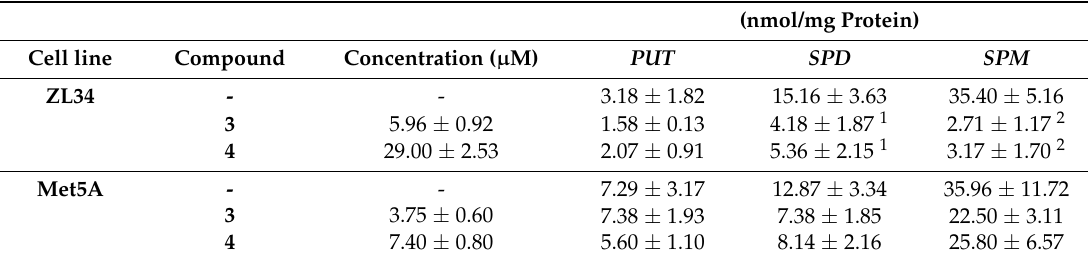
Table 4. Intracellular compound and polyamine concentrations (expressed nmol/mg protein). Cell lines ZL34 and Met5A were treated with 60 µ Μ of compounds 3 and 4 . Values presented as mean ± SD, obtained from three independent repetitions.